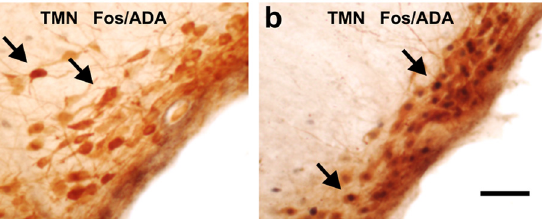
Fig 2. Photomicrograph of TMN neurons after re-exposure to the amphetamine place preferences apparatus. (a) Double immunohistochemistry for Fos/ADA in the tuberomamillary nucleus of a na ï ve (circadian control) rat. (b) Double immunohistochemistry for Fos/ADA in the TMN of an amphetamine conditioned rat, after 30 minutes of re-exposure to the amphetamine place preference apparatus. Arrows in (a) depict ADA-ir neurons; arrows in (b) depict double-ir neurons Fos/ADA. Scale bar, 200 μ m.